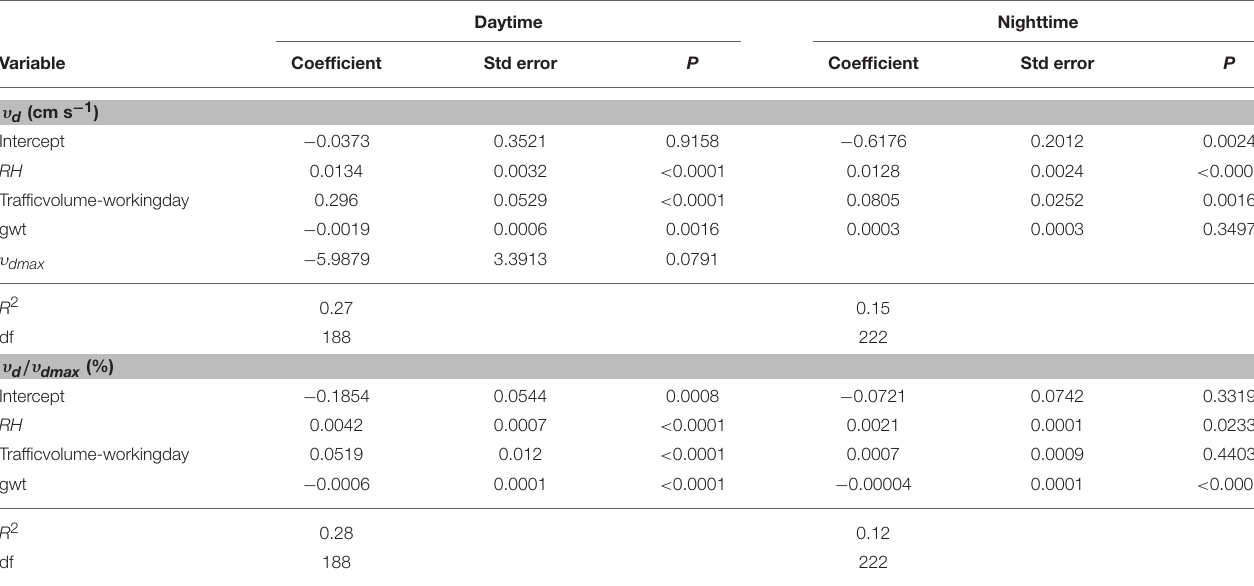
TABLE 3 | Results from the analysis of covariance.